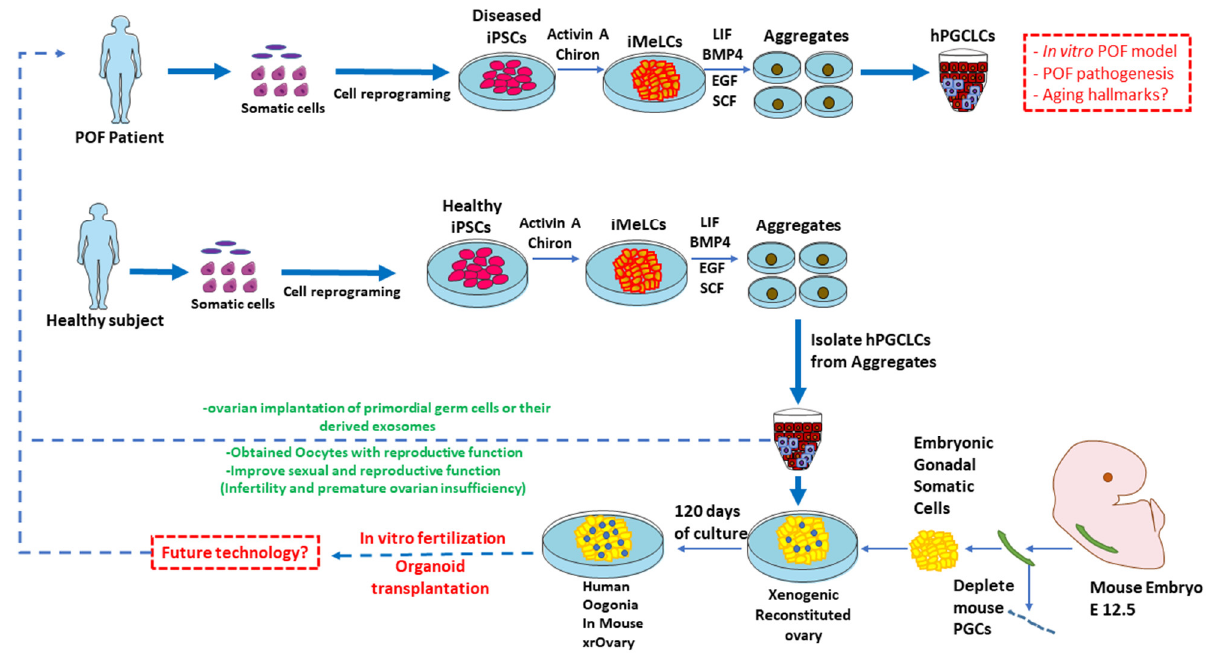
Figure 5. A schematic representation to generate primordial germ cells (PGCs) from POI patient cells for use as an in vitro POI model, and generate human oogonia in xrOvaries from healthy subject somatic cells as a future therapeutic option.